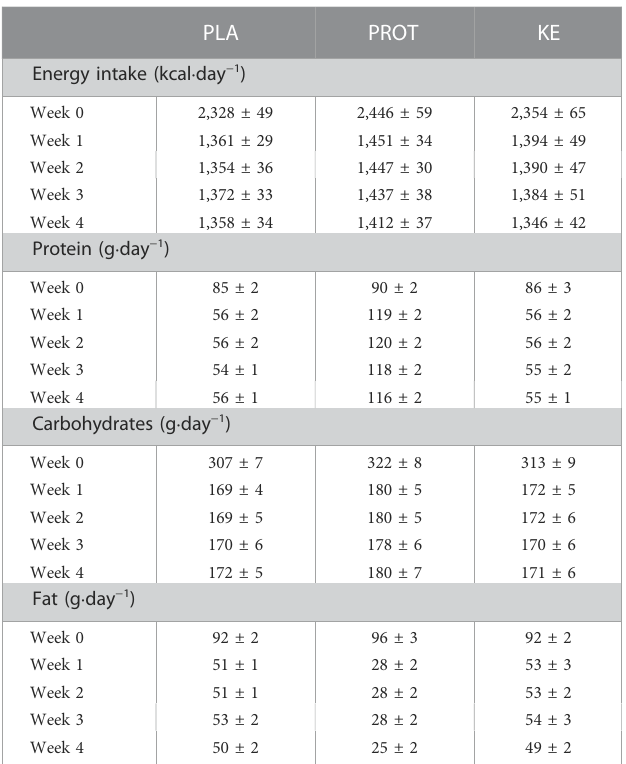
TABLE 1 Macro-nutrient composition of the experimental diets. Data are mean ± SEM.Energyintakereferstotheenergyintakeexclusive291 kcal · day − 1 delivered by the ketone and placebo supplements. Macronutrient composition is expressed in g per day. In week 0, the subjects received 100% of the estimated optimal energy intake in the form of a well-balanced mixed diet. In weeks one to four, total energy intake, i.e. nutrition plus supplement drinks, was reduced